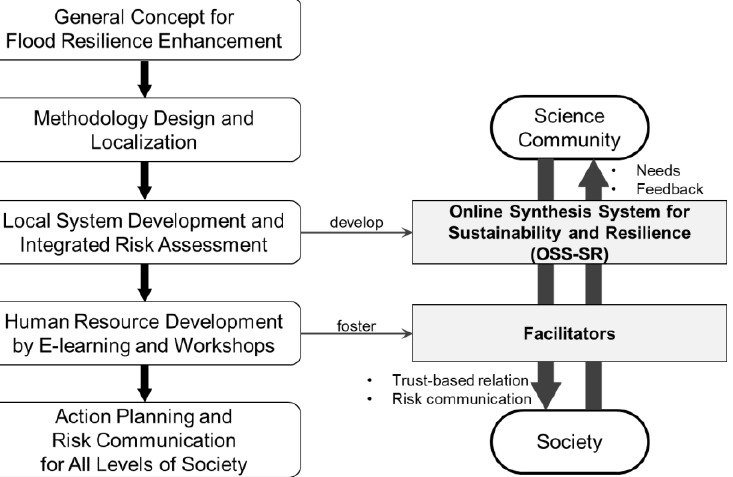
Figure 1. Structure of this study for formulating a method to enhance society-wide flood resilience based on co-design among relevant stakeholders.